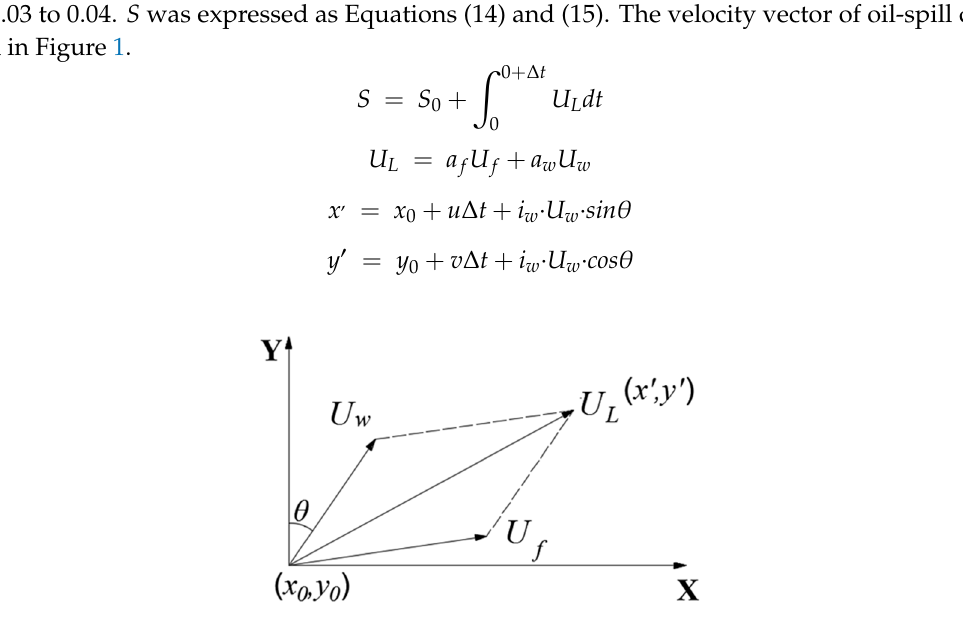
Figure 1. Velocity vector synthesis of oil-spill drift.